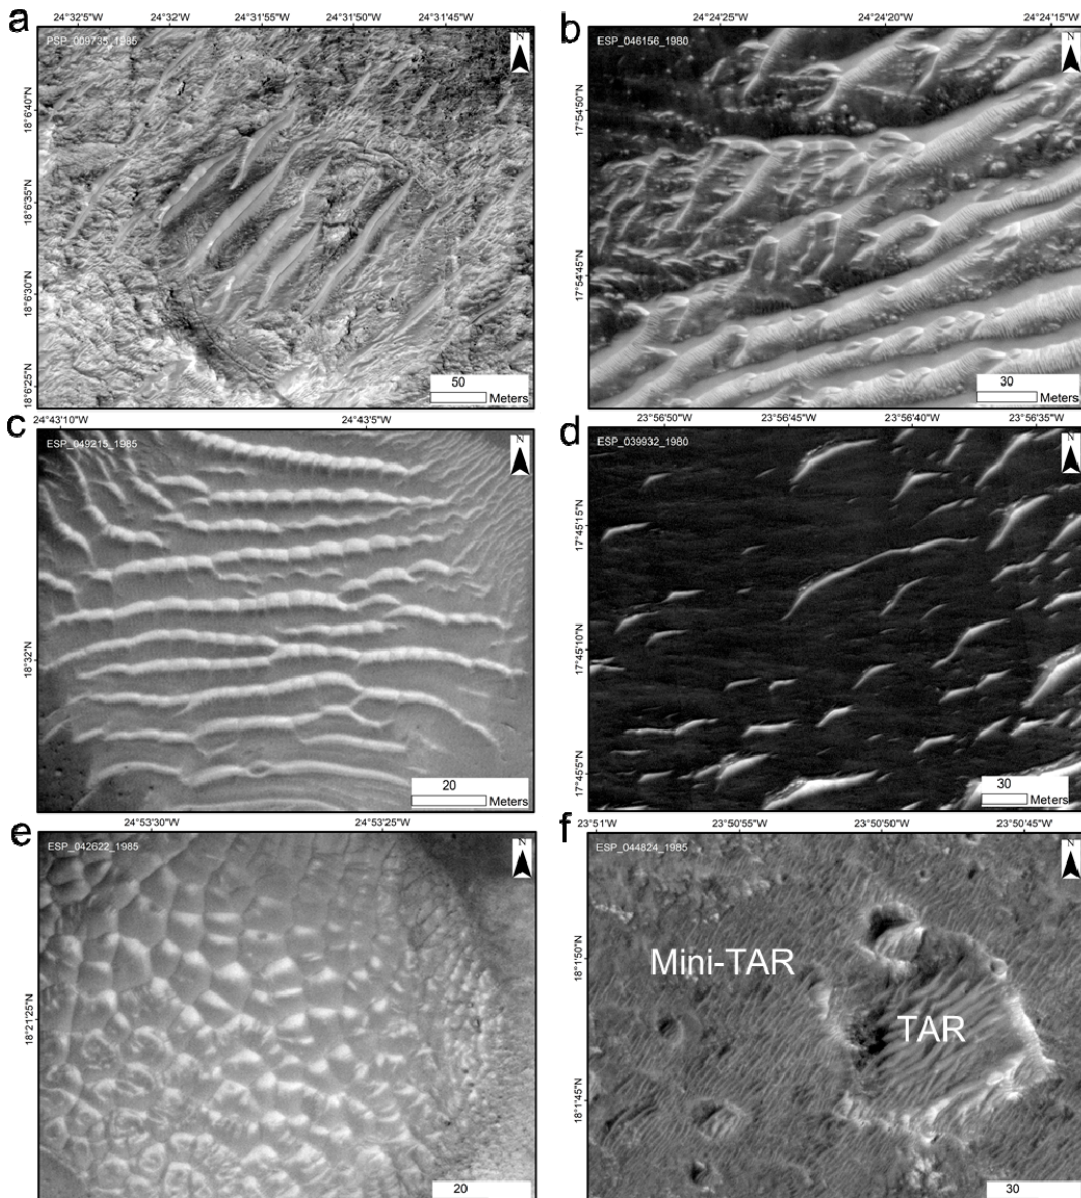
Figure 6. TAR morphologies in the study area: ( a ) simple TAR, ( b ) forked TAR, ( c ) wavy TAR with associated smaller secondary ripples, ( d ) barchan-like TAR, ( e ) networked TAR, and ( f ) mini-TARs. HiRISE image credit: NASA/JPL/University of Arizona.